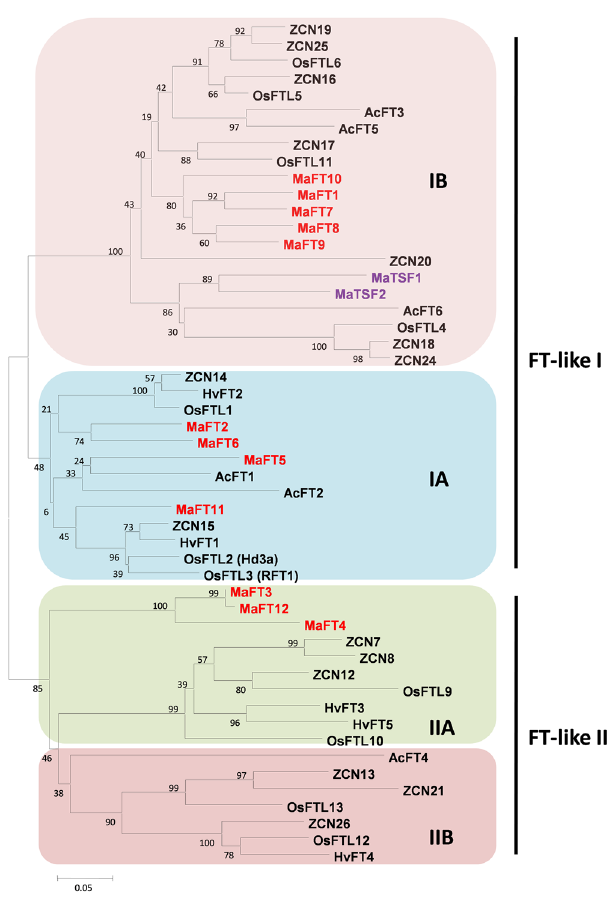
Figure 3. Phylogenetic analysis of banana FT/TSF-like family proteins with those from other monocots. The banana FT-like genes are shown in red, while TSF-like are in purple. Sequences were aligned with ClustalW and the tree was constructed with MEGA6.0 software using neighbour-joining analysis. The bootstrap values are shown in numbers in each branch for 1000 repetitions in percentage. The scale bar (0.05) reflects the amino acid substitution frequency as established by Poisson corrective distance model. Accession numbers are provided in Supplementary Tables S7 and